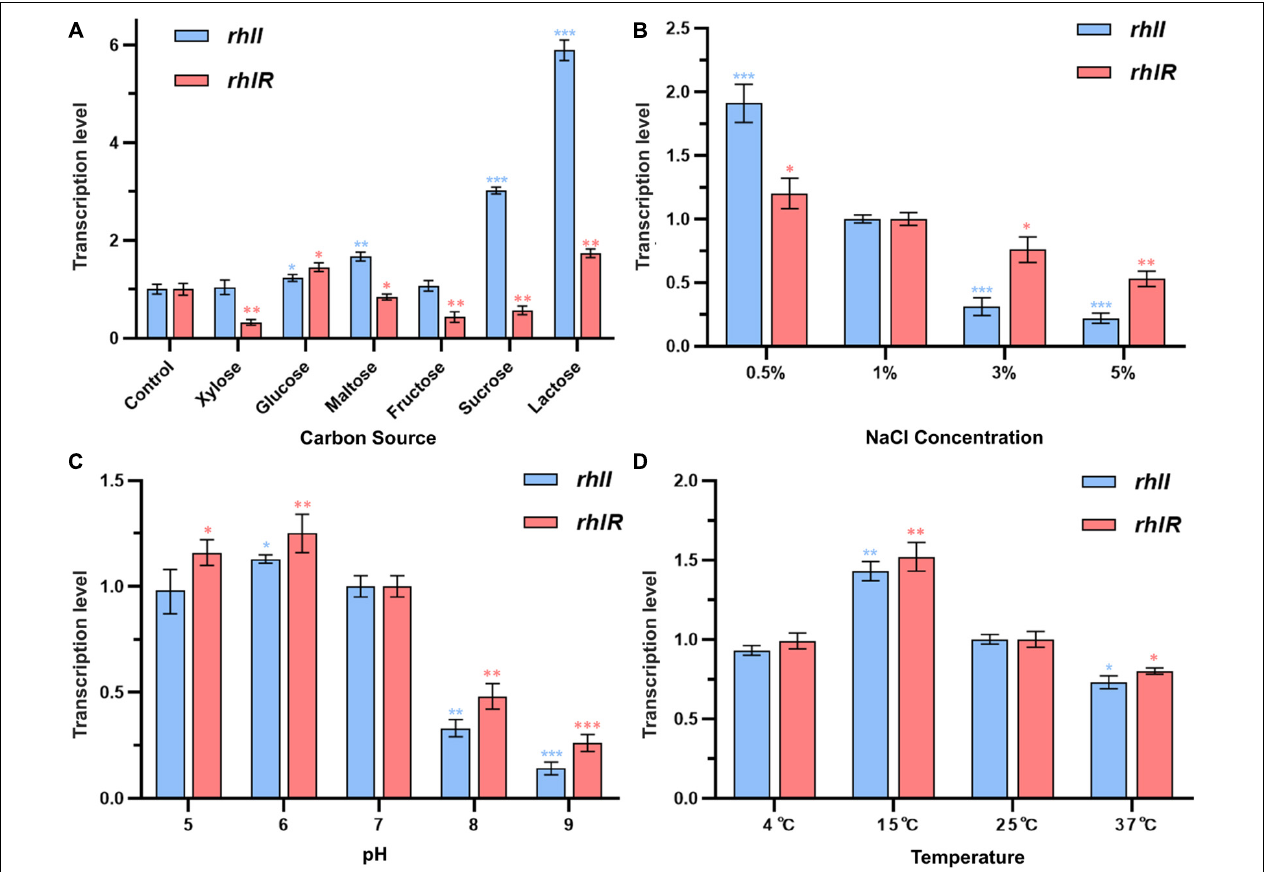
FIGURE 5 | Transcription levels of rhlI/R genes in Pseudomonas fluorescens PF08 after incubation in different conditions until an optical density at 595 nm (OD 595) of 1 was reached. (A) Different carbon sources in culture medium; (B) different NaCl concentrations of the culture medium; (C) different pH of the culture medium; (D) different temperatures during incubation. Data are presented as means ± SD ( n = 3, ∗ P < 0.05, ∗∗ P < 0.01, ∗∗∗ P <